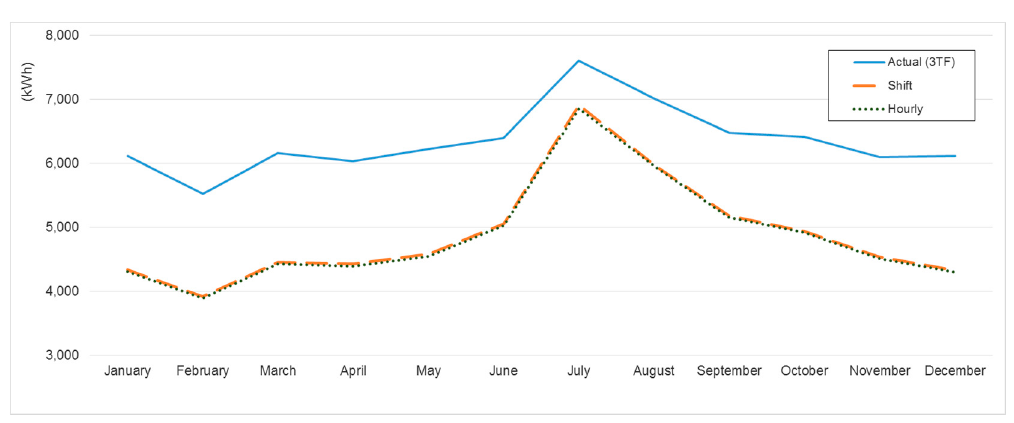
Figure 6. Monthly energy losses on Sec SS 3 with the three control systems for the number of connected transformers. Table 6. Percentage of losses on Sec SS 3 with respect to the permanent connection of three transformers